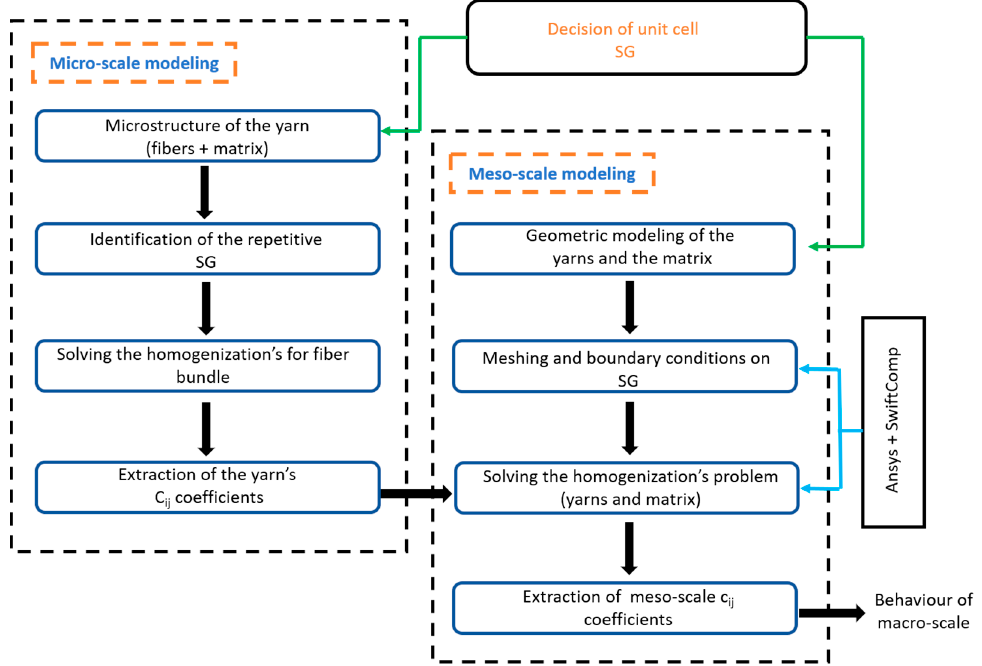
Figure 5. Two-step homogenization process.